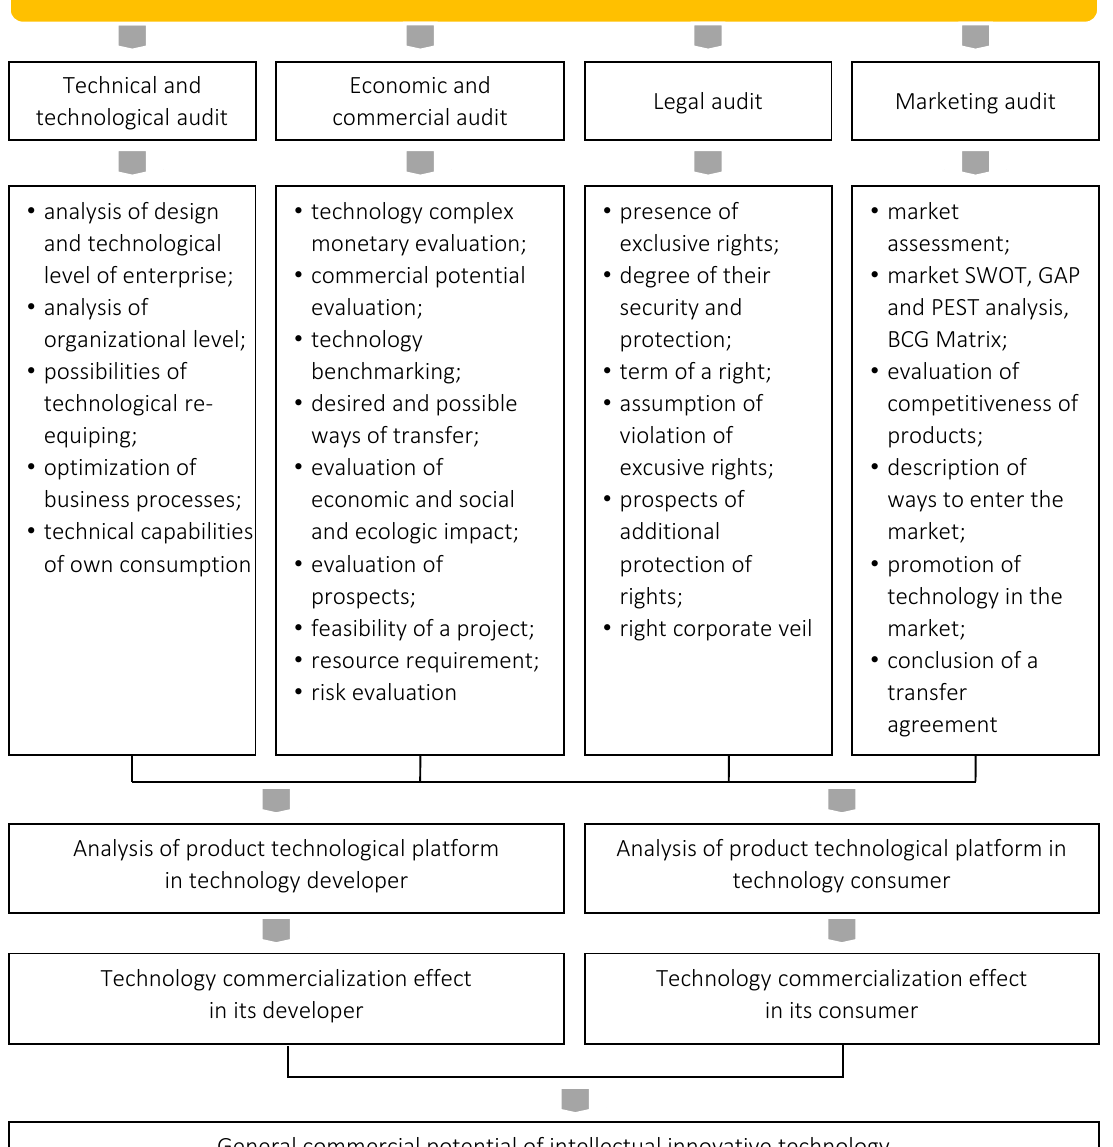
Figure 3. Structural logical (conceptual) scheme of technology audit of innovative